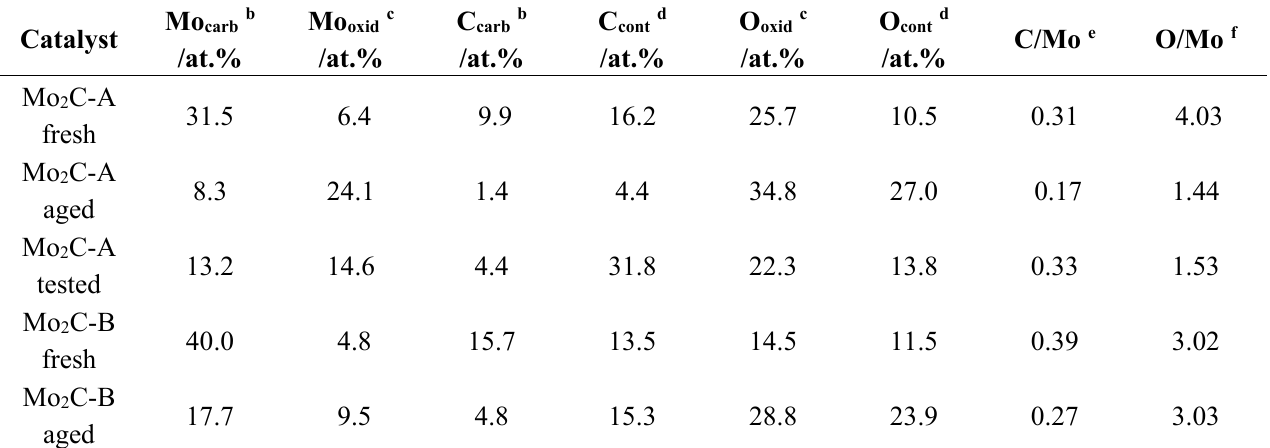
Table 2. Surface composition of Mo 2 C catalysts analyzed by XPS a